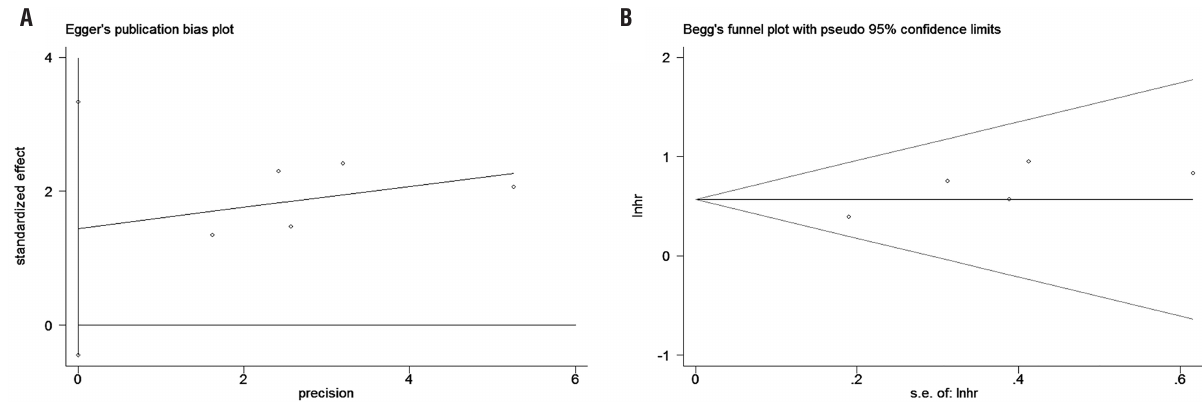
Figure 5 - Publication bias of OS: A: Egger’s test; B: Begg’s test.